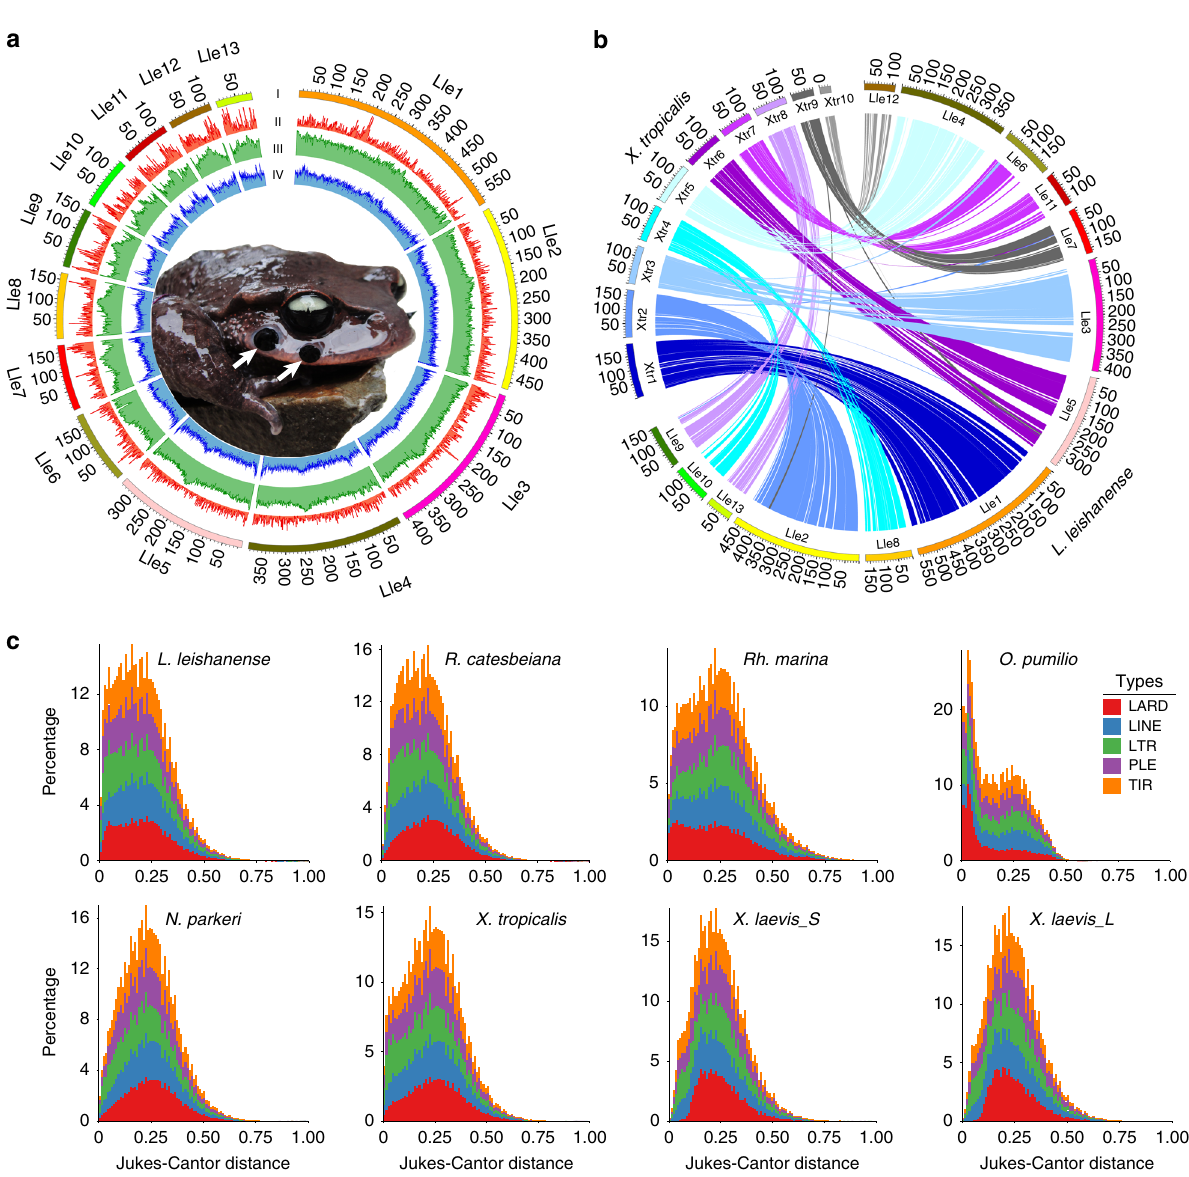
Fig. 1 Genomic landscape of Leptobrachium leishanense and comparison with other anurans. a From outer to inner: (I) sizes of 13 pseudochromosomes; (II) gene density (the percentage of genes in per 200-kb window); (III) repeat sequence distribution; (IV) GC content (%). The photo in the circle shows an adult male with nuptial spines on the upper jaw as marked with two white arrows (two spines on each side). The toad photo was taken by Wei Zhang. b Chromosome synteny between L. leishanense and X. tropicalis . Chromosomes of X. tropicalis are marked as “ Xtr1 – 10 ” and chromosomes of L. leishanense are marked as “ Lle1 – 13 ” . Collinear blocks between two species are linked by lines with the same colors. c Divergence distribution of fi ve dominant transposable elements (TEs) in different genomes based on the same analysis procedures (see “ Methods ” ). The x -axis is the Jukes – Cantor distance from the consensus in the TE library. The y -axis shows percentages of TE occupancy in genomes. LARD large retrotransposon derivatives, PLE Penelope-like elements, TIR terminal inverted